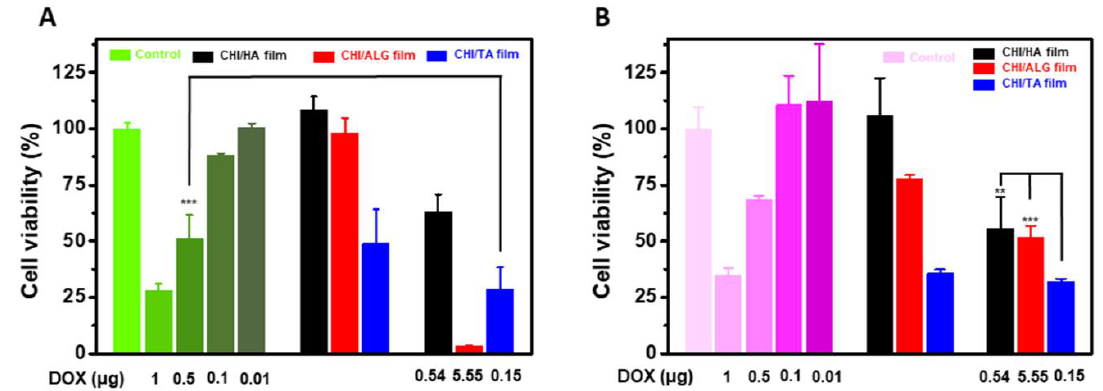
Figure 8. Film toxicity and anticancer effect of DOX-incorporated multilayer films. ( A ) Cell viability of HeLa cells and ( B ) KATO III cells. ** and *** suggest that p value is smaller than 0.01 and 0.001, respectively.